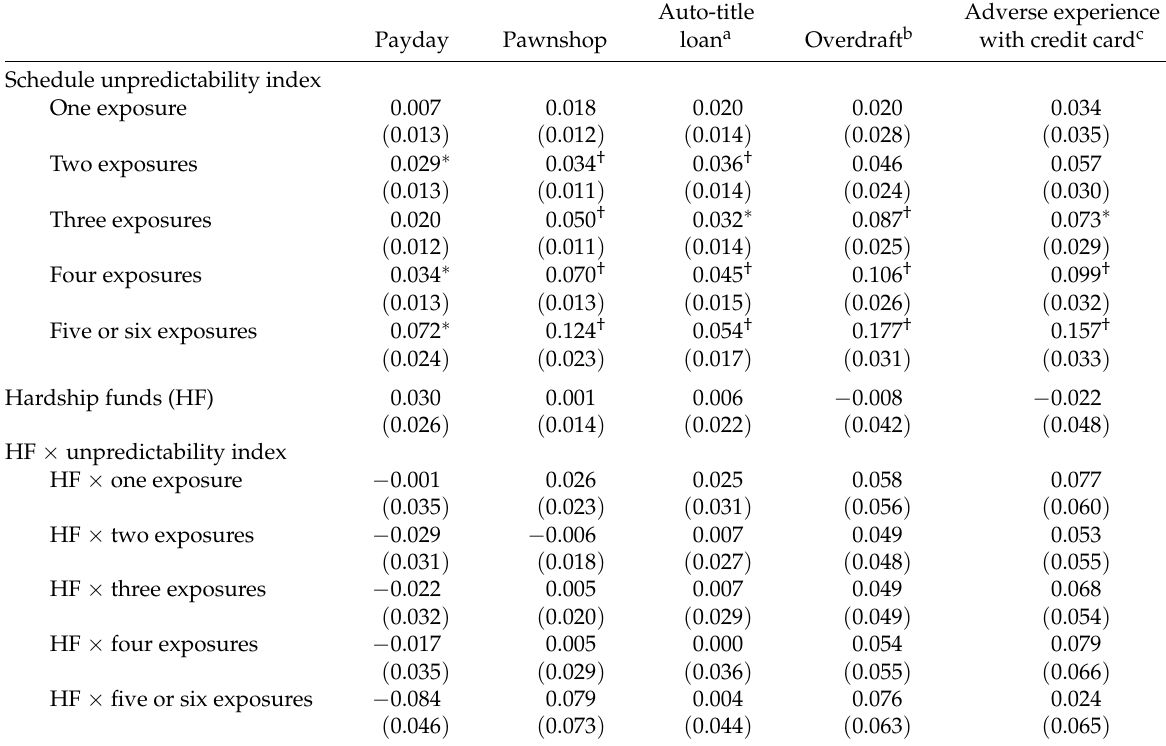
Table 7: Coefficients from linear probability models